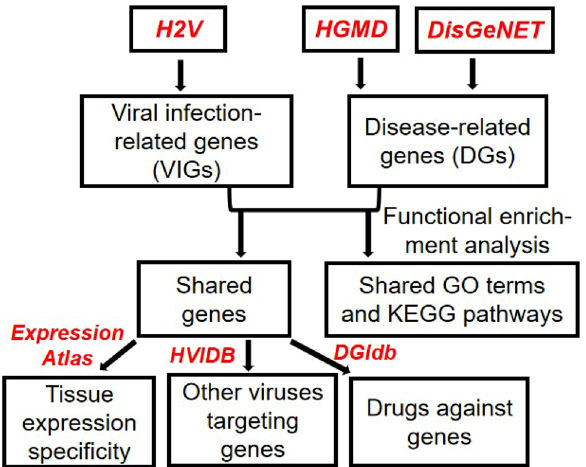
Figure 1. The workflow of the study. The database names were shown in italic and colored in